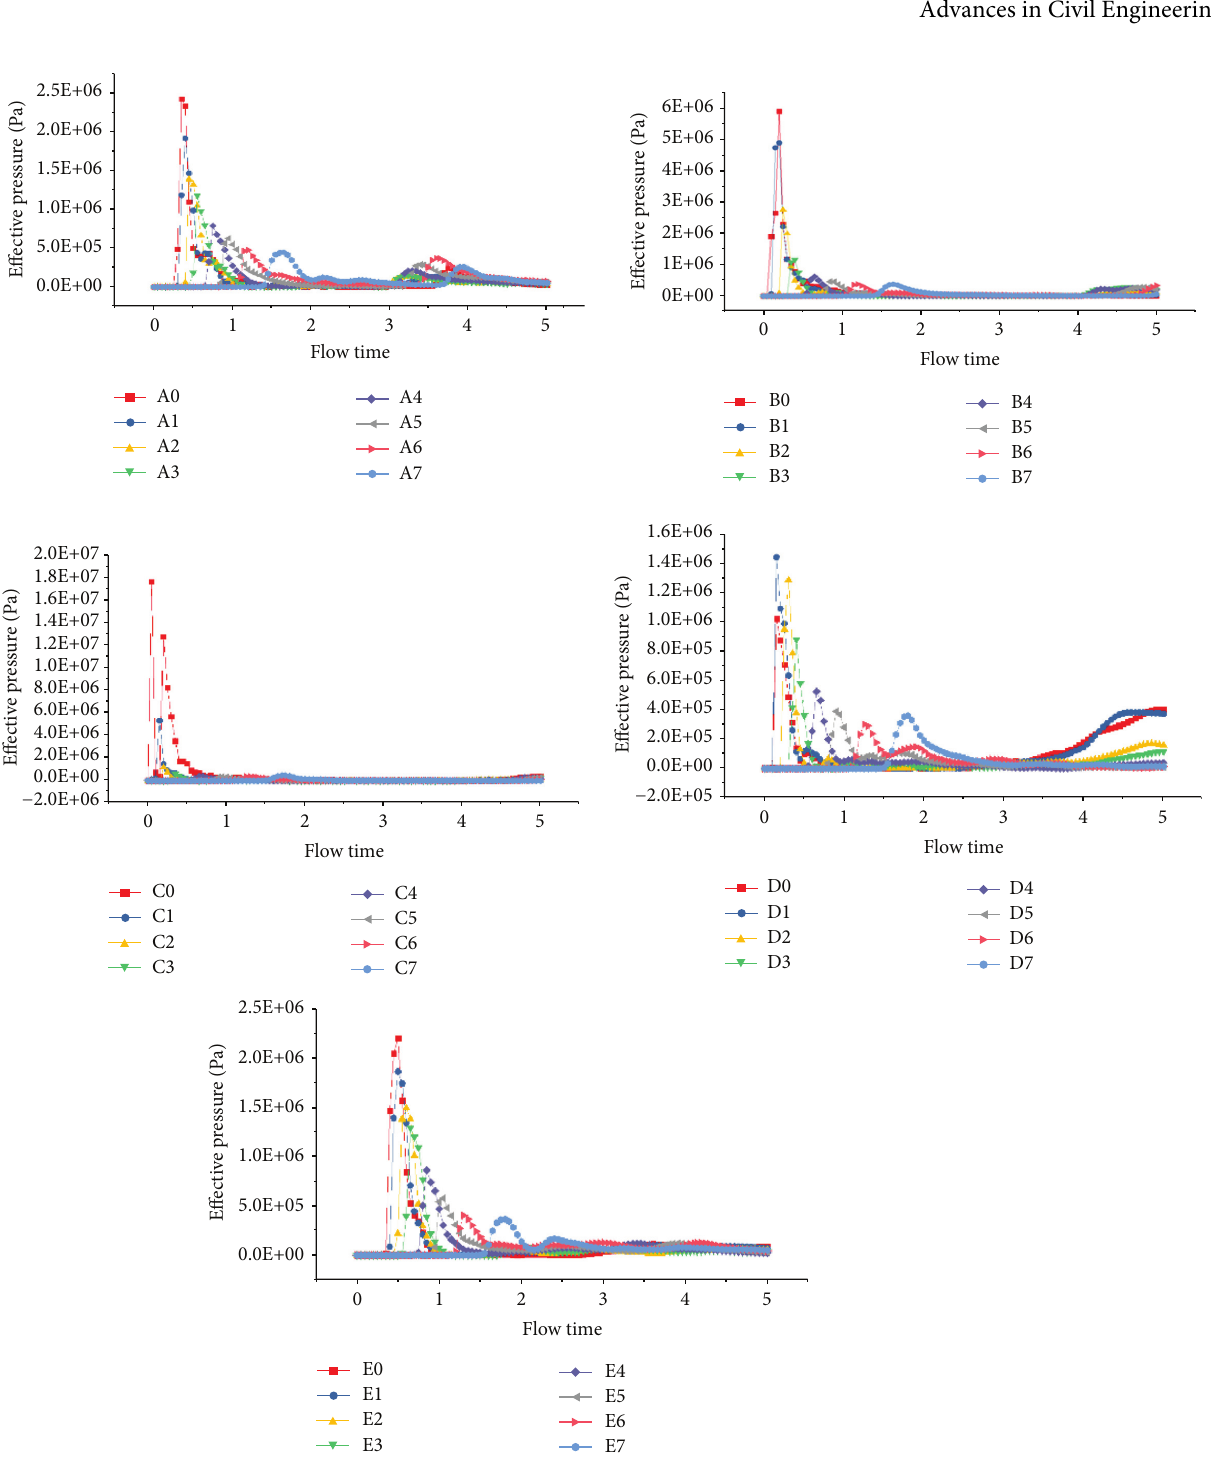
Figure 6: The compressive wave at the monitoring points